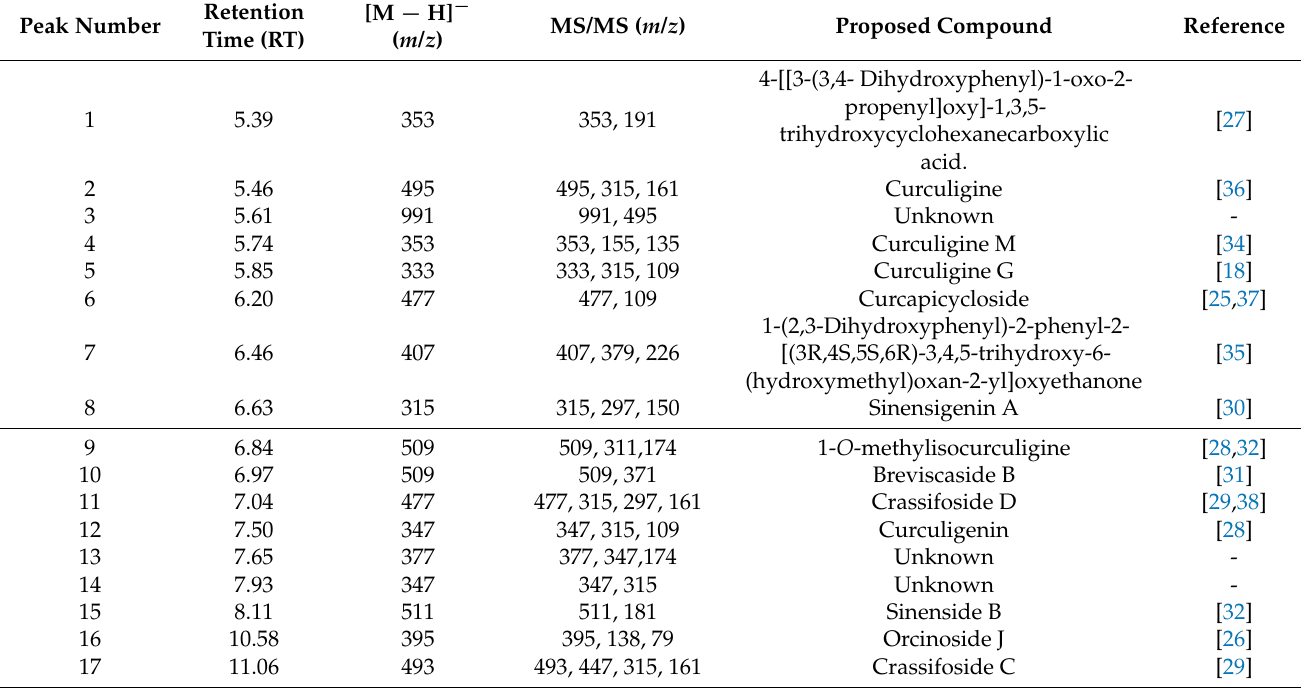
Table 1. Annotated compounds based on LC-MS/MS and MN in the rhizome extract of Curculigo latifolia . The table shows peak number, proposed compound, retention time in minutes (RT), parent ion [M − H] - mass per charge ratio, MS/MS mass per charge ratio of fragment ions, and